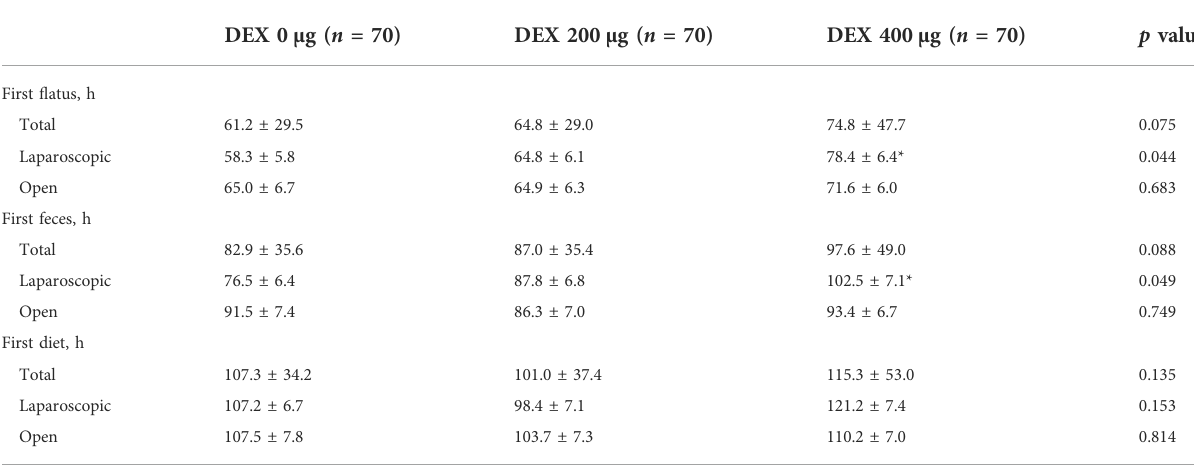
TABLE 2 Postoperative gastrointestinal motility